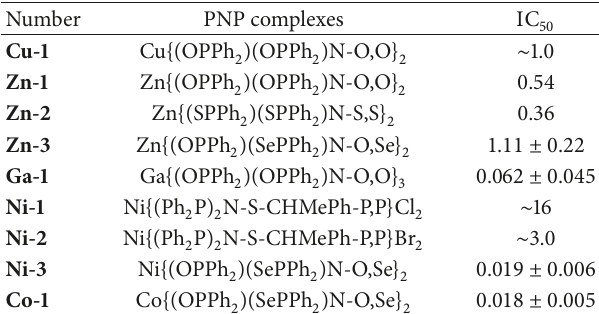
Table 3: IC 50 data ( 𝜇 M) final concentration in the aggregometer cuvette for metal complexes bearing PNP ligands as PAF